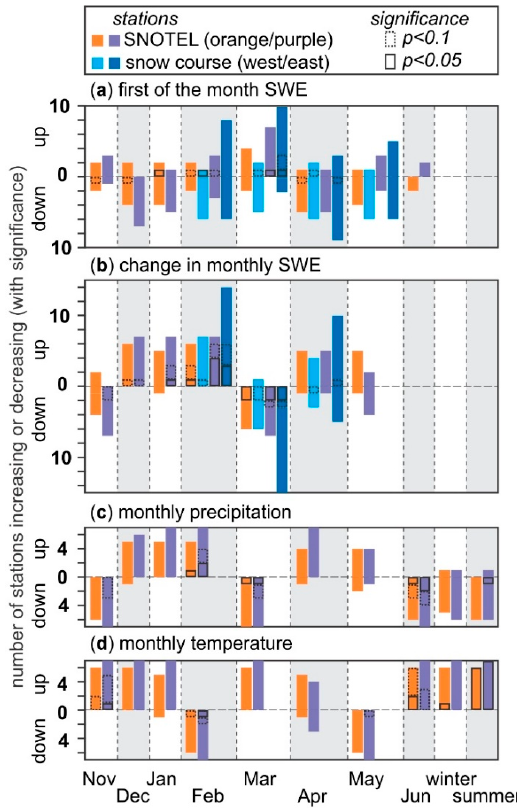
Figure 3. The numbers of stations per month representing the increasing (up) or decreasing (down) trends with the significant (solid line) and marginally significant (dashed line) stations at p < 0.05 and p < 0.10, respectively, characterized by west (orange: Snowpack Telemetry (SNOTEL); light blue: snow course) and east (purple: SNOTEL; dark blue: snow course) stations for ( a ) first of the month’s snow water equivalent (SWE) trend (see Figure 2); ( b ) change in monthly SWE trend, ( c ) monthly precipitation (see Figure 6b), and ( d ) monthly temperature (see Figure 6c). For ( a , b ), the snow course stations are included.